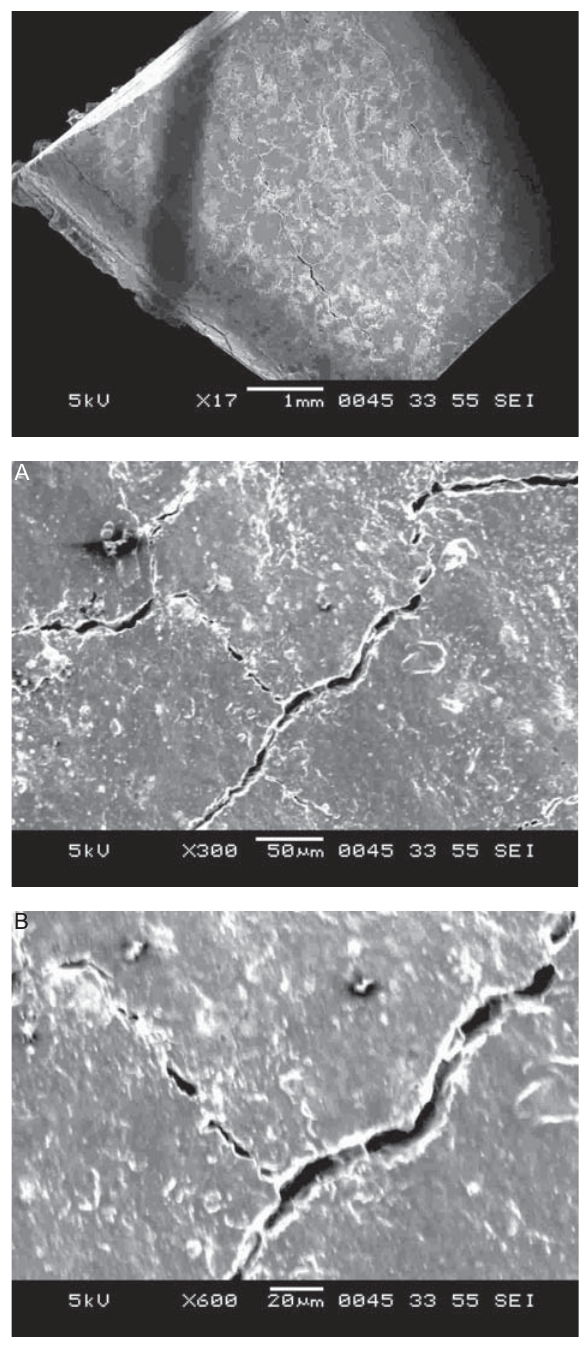
Figure 5- Scanning electron microscopy (SEM) view of group C sample. A: SEM view of group C sample at 300x (cid:2)(cid:3)(cid:4)(cid:5)(cid:6)(cid:7)(cid:8)(cid:3)(cid:9)(cid:6)(cid:10)(cid:5)(cid:11)(cid:12)(cid:13)(cid:14)(cid:12)(cid:15)(cid:16)(cid:17)(cid:12)(cid:18)(cid:6)(cid:19)(cid:20)(cid:12)(cid:10)(cid:21)(cid:12)(cid:4)(cid:22)(cid:10)(cid:23)(cid:24)(cid:12)!(cid:12)(cid:26)(cid:3)(cid:2)(cid:24)(cid:27)(cid:19)(cid:12)(cid:3)(cid:9)(cid:12)(cid:28)(cid:29)(cid:29)(cid:30)(cid:12)